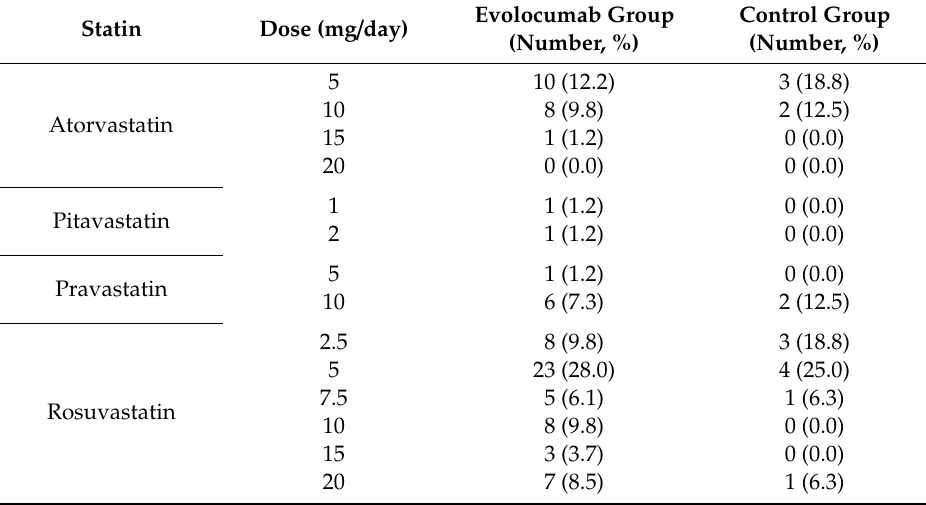
Table 2. Dose of each statin administered in the evolocumab and control groups.